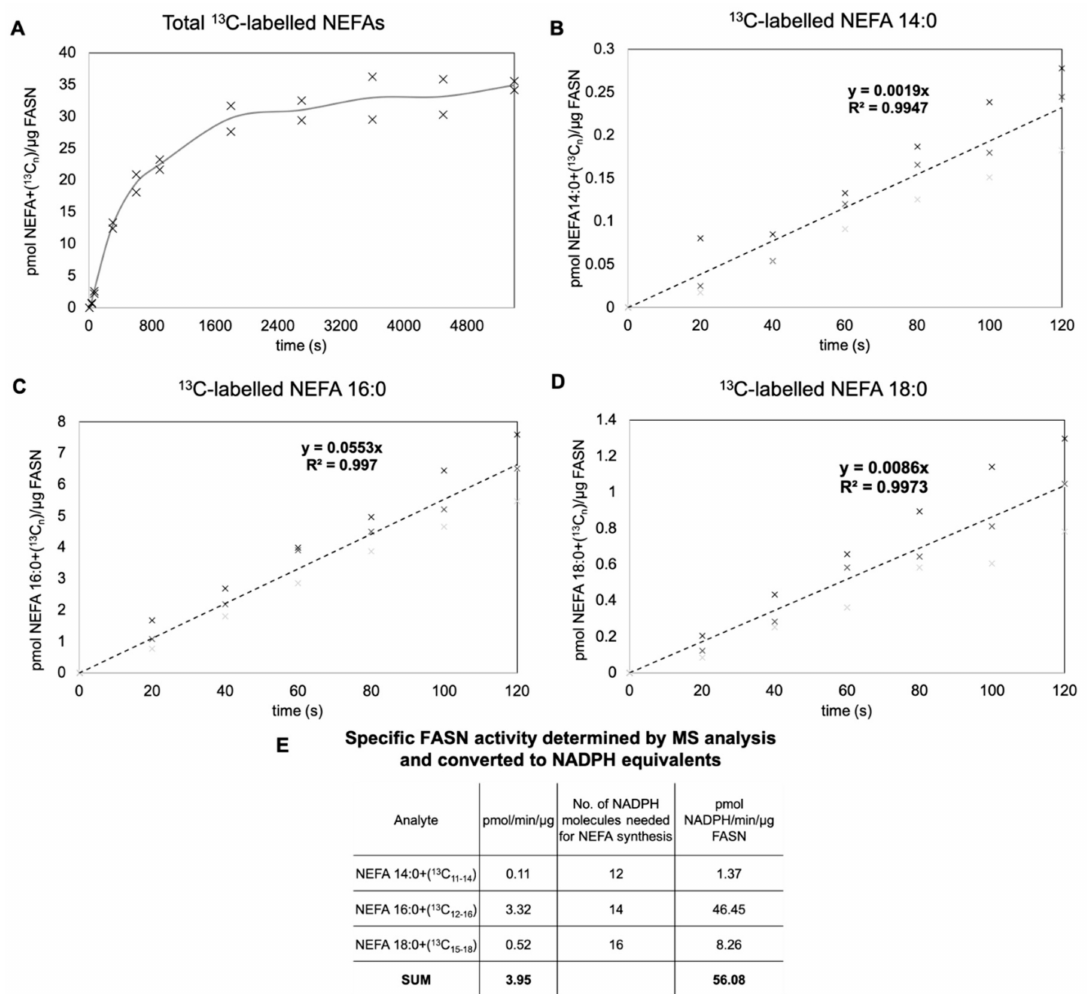
Figure 3. Determination of specific FASN activity. ( A ) Time series analysis of total de novo synthetized 13 C-labeled NEFAs across a 90 min period. Purified FASN was incubated with 13 C 3 -malonyl-CoA, acetyl-CoA, and NADPH at 37 ◦ C for the indicated times. The reaction mixtures were extracted using a Bligh and Dyer-based approach without sample evaporation. Extracts were analyzed directly by FTMS on an Orbitrap Fusion Tribrid mass spectrometer and 13 C-labeled NEFAs were quantified using the internal standard NEFA 16:0( + 2 H 4 ). Data represent average values and dots individual measurements ( n = 2 independent reactions extracted and analyzed separately). ( B – D ) Time series analysis of de novo synthetized 13 C-labeled NEFA 14:0, 16:0, and 18:0 across a 2 min period, representing the initial rate of the FASN-catalyzed reaction. The assay was carried out as outlined in (A). Data represent average values and dots individual measurements ( n = 3 independent reactions extracted and analyzed separately). Lines represent linear regressions having the indicated slope values and regression coe ffi cients. ( E ) Summary of estimated specific FASN activity for di ff erent NEFA species and calculation of total specific activity in terms of NEFAs and NADPH